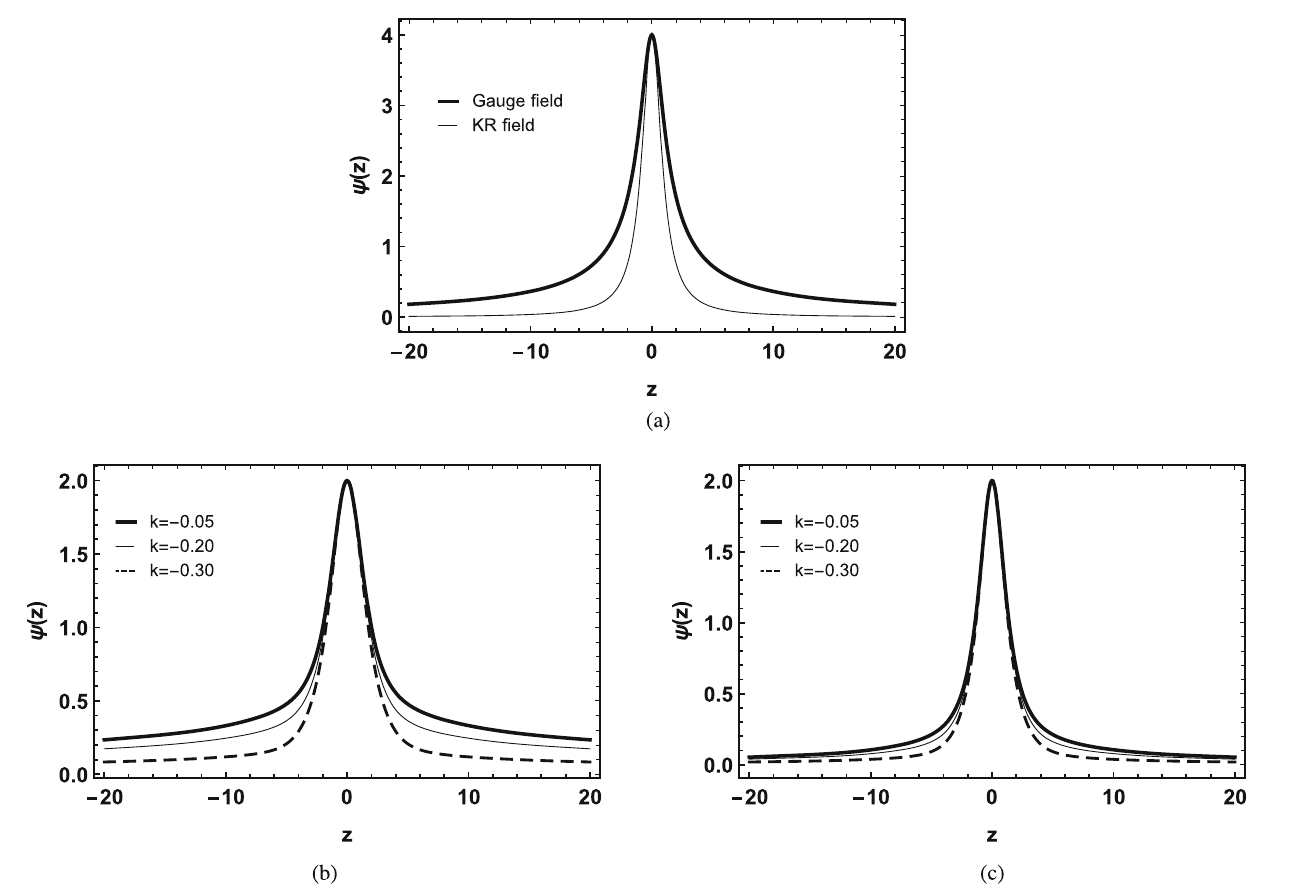
Fig. 4 Behavior of massless modes for G 1 (φ) with p = λ = 1. a n = 1. Being b = 4 and n = 2. b Gauge field. c KR field